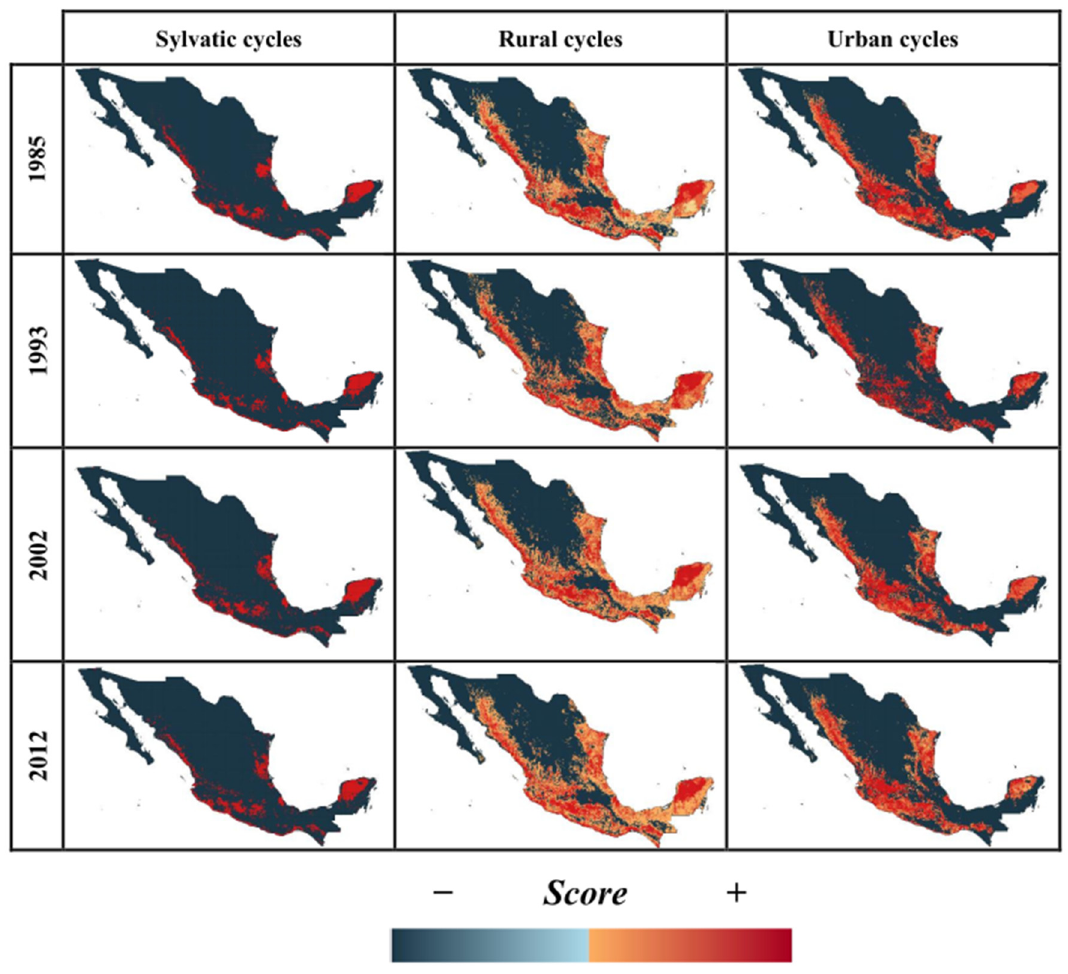
Figure 4. Potential distribution of each type of T. cruzi transmission cycle under historical conditions of land-use and land-cover-change and climate. The change from blue to red indicates a gradient from unsuitable (negative score) to suitable (positive score) ecological conditions.